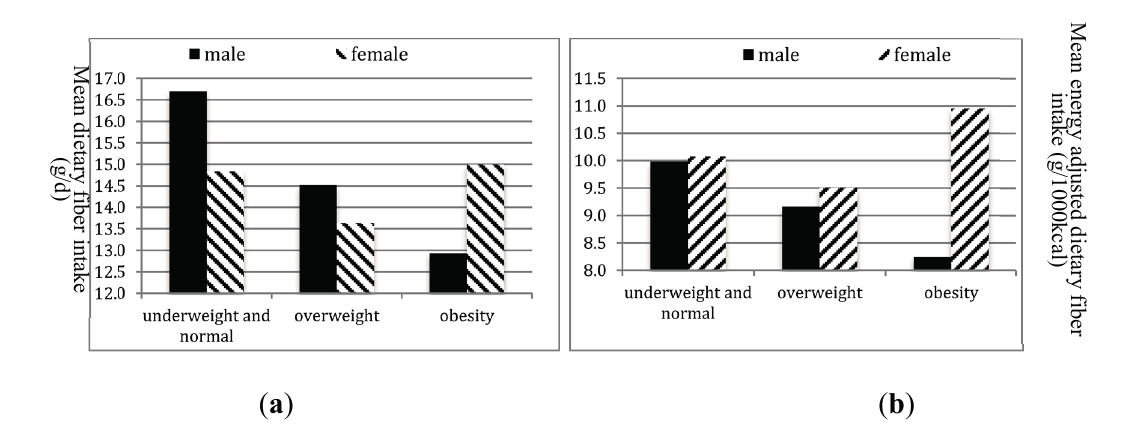
Figure 1. Mean ( a ) total and ( b ) energy-adjusted dietary fiber intakes by BMI category stratified by gender of rural-to-urban participants.